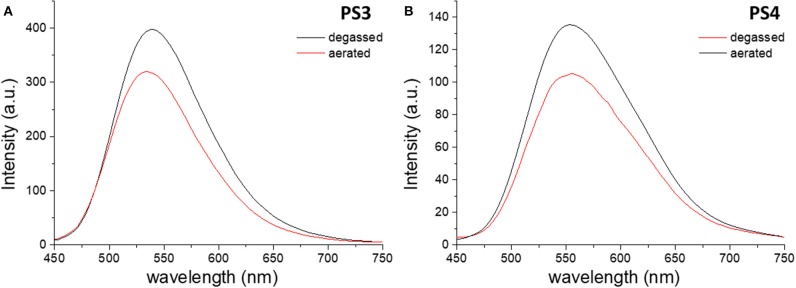
Steady-state emission spectra of PS3 (A) and PS4 (B) in aqueous suspension collected before (red) and after (black) degassing. λex = 420 nm.